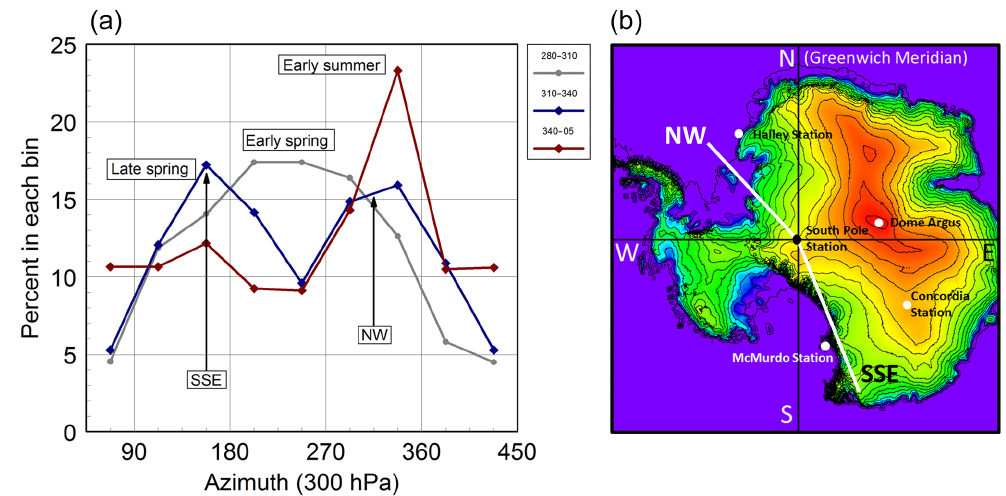
Figure 2. (a) Histograms of wind directions sorted in 45 ◦ bins ( > 5ms − 1 ) at 300hPa for early spring (Days 280–310, gray line), late spring (Days 310–340, blue line), and early summer (Days 340–370, red line) over the period 1990–2013 (For more detail see Fig. S1). (b) Topographic map of Antarctica. In late winter/early spring winds aloft are primarily from the direction of West Antarctica and the Amundsen Sea (south to northwest). In late spring, 300hPa winds become semi-bimodal in direction, with higher probabilities from south- southeast and northwest and fewer from the west-southwest. Past work has indicated that winds from the southeast quadrant bring cooler temperatures and lighter wind speeds to the SP: this direction corresponds to an inland directed synoptic-scale pressure gradient. Conversely, 300hPa winds centered on the northwest quadrant are typically associated with higher surface winds, increased cloudiness, and warmer temperatures: this direction reflects an off-shore directed synoptic pressure gradient. In early summer, winds at 300hPa increasingly favor a north-northwest direction from the Weddell Sea.